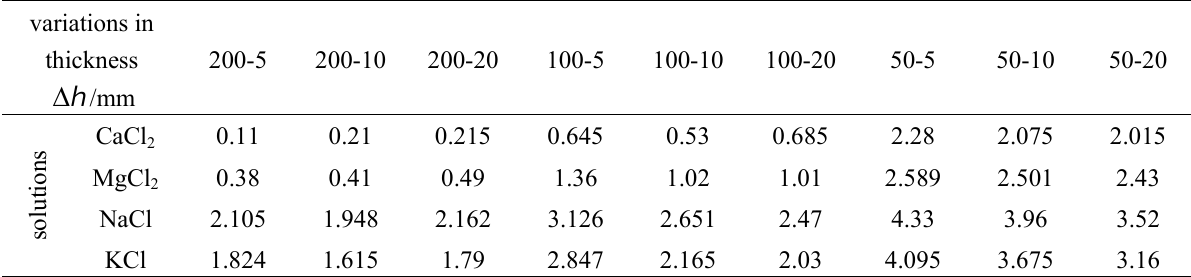
Table 4. Variations in thickness of GCL specimens after soaking.